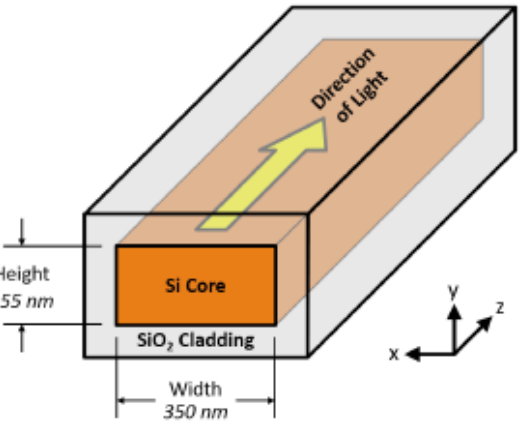
Figure 9. Example of a typical, silicon-integrated waveguide (after